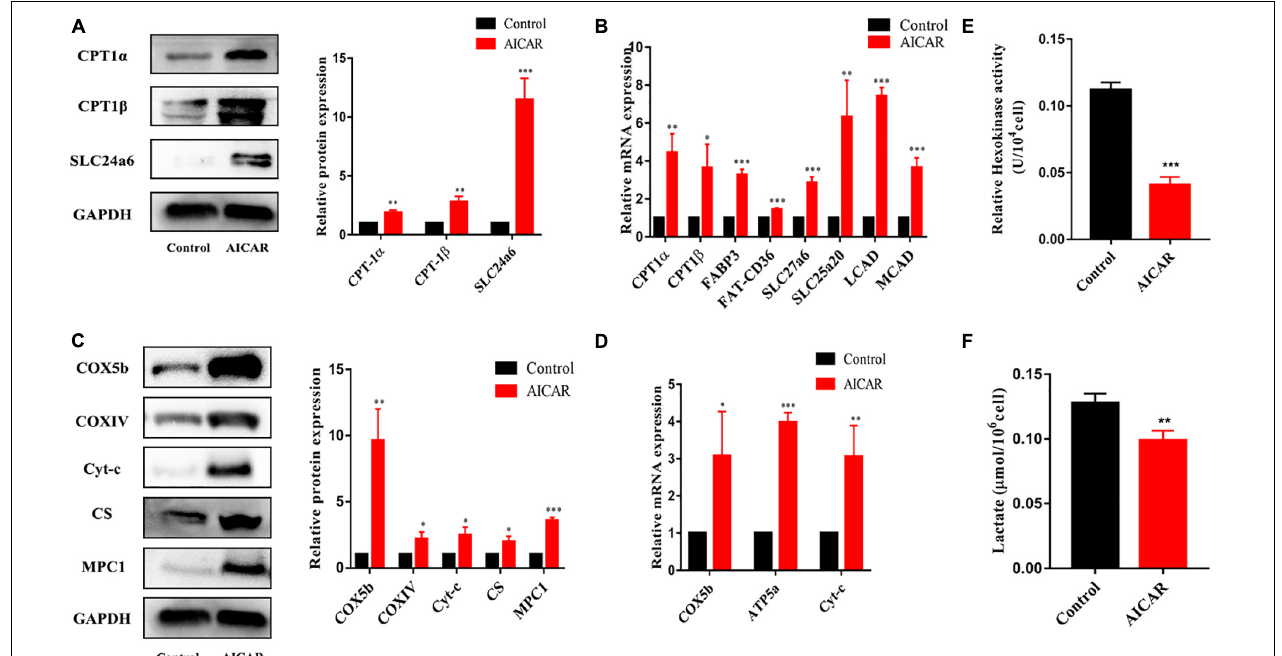
FIGURE 4 | The effects of AMPK activation on the expression of the downstream metabolism-related targets. For (A,C) , the same membrane was probed for the indicated proteins, with GAPDH used as the loading control. (A) Western blot analysis of the expression of fatty acid β -oxidation-related proteins (CPT-1 α , CPT-1 β , and SLC24a6) in hiPSC-CMs treated with AICAR (vs. control) ( n = 3). (B) RT-qPCR analysis of the effect of AICAR on the expression of fatty acid β -oxidation-related genes (CPT-1 α , CPT-1 β , FABP3, FAT-CD36, SLC27a6, SLC25a20, LCAD, and MCAD) ( n = 3). (C) Western blot analysis of the expression of mitochondrial OxPhos-related proteins (COX5b, COXIV, Cyt-c, C-S, and MPC1) in hiPSC-CMs treated with AICAR (vs. control) ( n = 3). (D) RT-qPCR analysis of the effect of AICAR on the expression of mitochondrial OxPhos-related genes (COX5b, ATP5a, and Cyt-c) ( n = 3). (E) Relative hexokinase enzyme activity in hiPSCs treated with AICAR or control ( n = 3). (F) Lactate measurements of hiPSCs treated with AICAR or control ( n = 3). * P < 0.05, ** P < 0.01, *** P < 0.001 compared with the control group, unpaired t